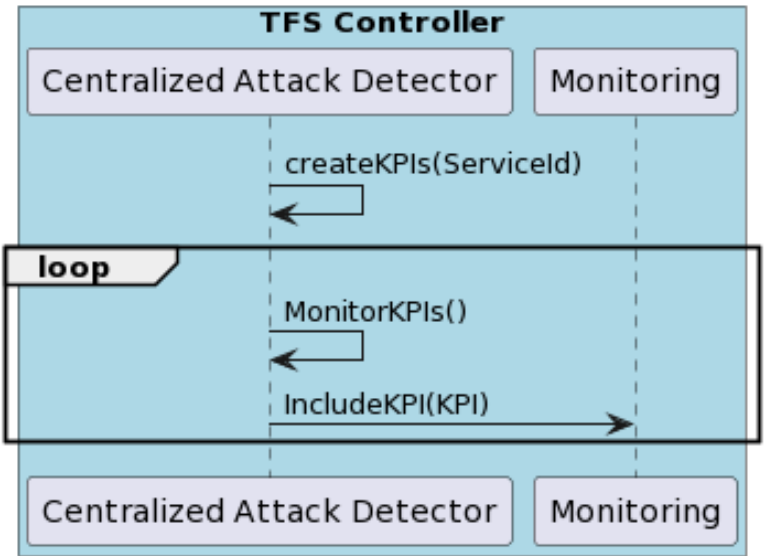
Figure 7. Monitoring component